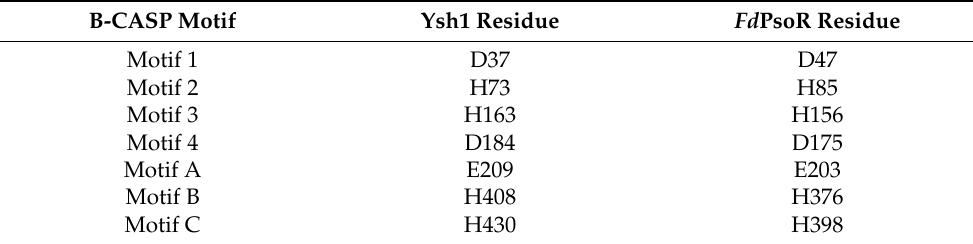
Table 2. The seven conserved motifs of β -CASP proteins present in Fd PsoR and Ysh1. Motifs 1–4 are found in the Metallo- β -lactamase superfamily of proteins involved in the hydrolysis of different substrates. In addition to these four motifs are motifs A, B, and C found in β -CASP domain-containing proteins involved in nucleolytic activity, using DNA and RNA as substrates. The motifs, in particular, are involved in metal binding, such as zinc and magnesium, to form the catalytic reaction center of the protein where cleavage